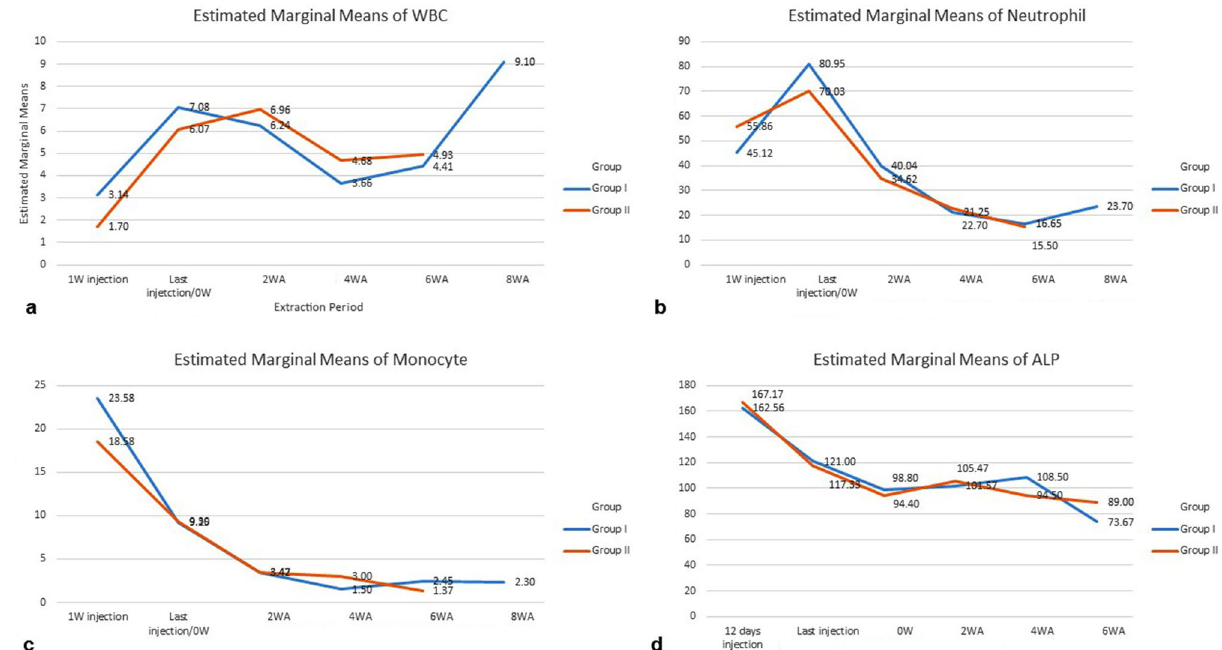
Figure 4. Laboratory results of blood testing for white blood cells ( a ), neutrophils ( b ), monocytes ( c ), and ALP ( d ) show changes in the status of inflammatory markers after the administration of pamidronate in the developing BRONJ model.